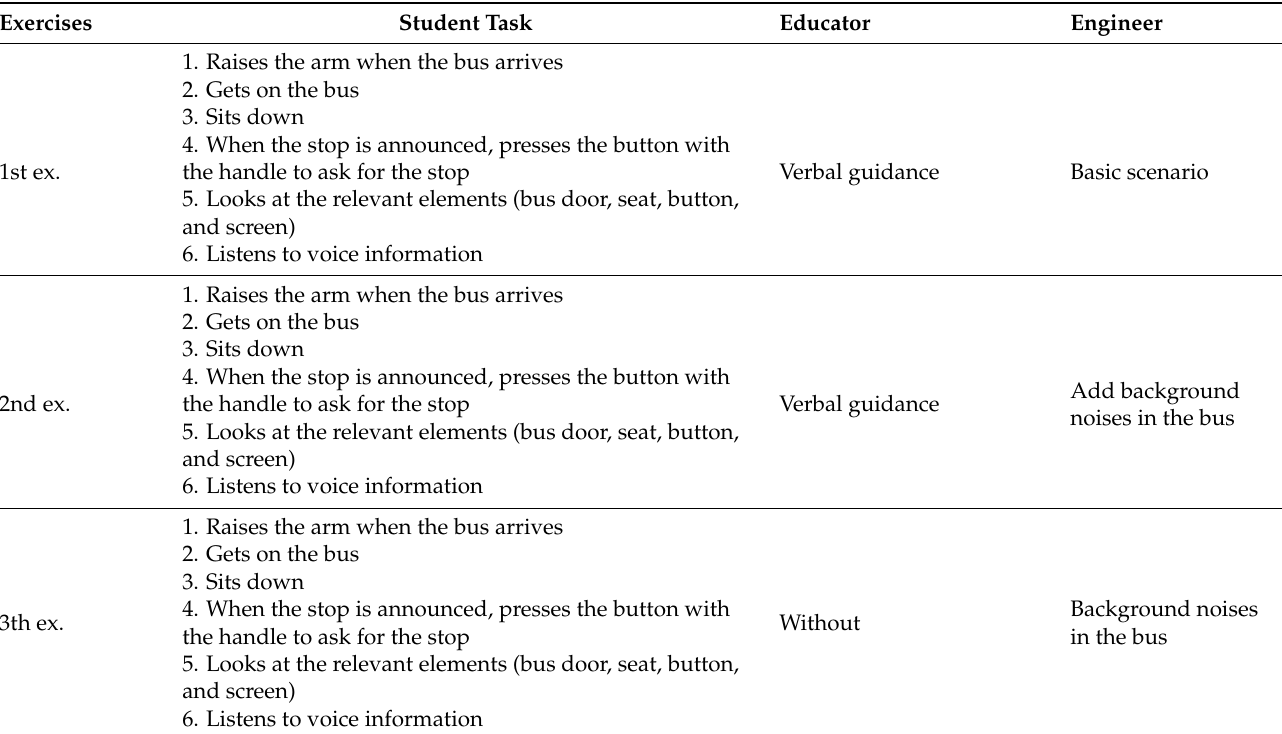
Table A4. Example of one sequence of